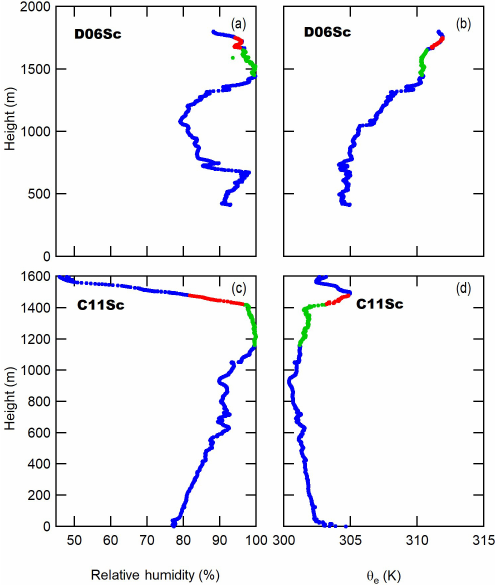
Figure 11. UAV vertical profiles of relative humidity (a, c) and θ e (b, d) for flights D06Sc and C11Sc, used in Fig. 10. Profiles are de- fined as cloud-free (blue), in-cloud (green) or entrained-air sources